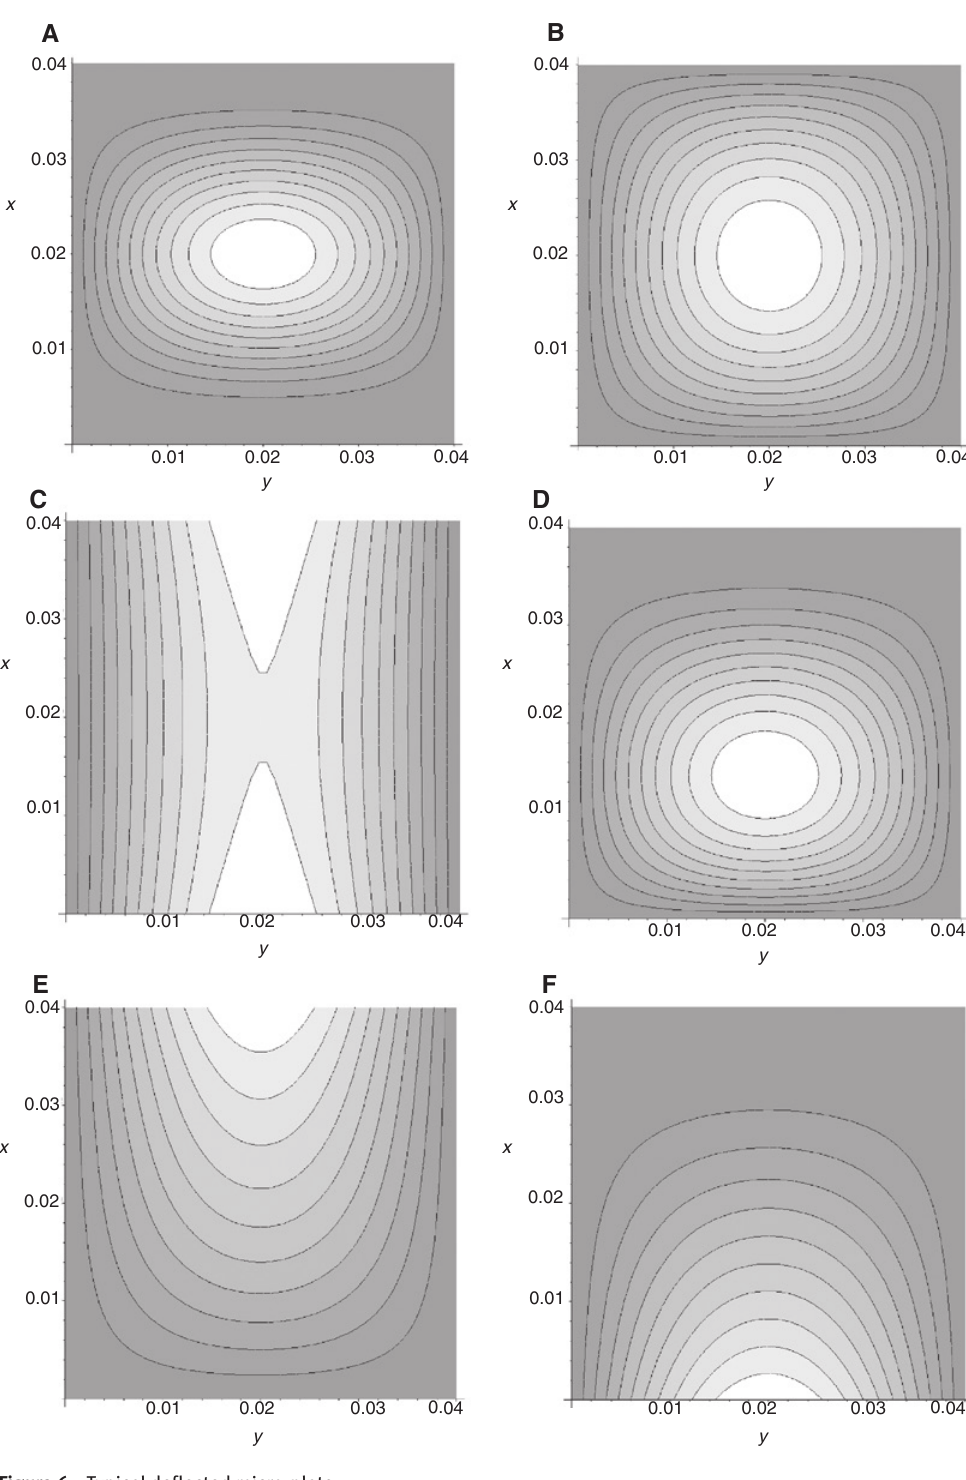
Figure 6: Typical deflected micro-plate. (A) SCSC micro-plate, (B) SSSS micro-plate, (C) SFSF micro-plate, (D) SSSC micro-plate, (E) SSSF micro-plate, and (F) SFSC